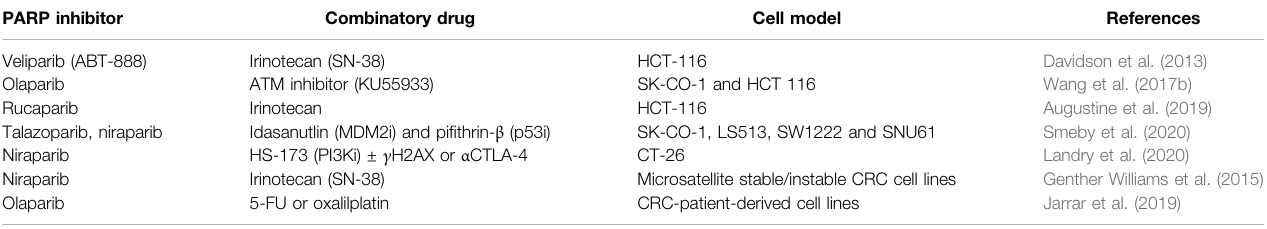
TABLE 1 | PARP inhibitors in different cell models.